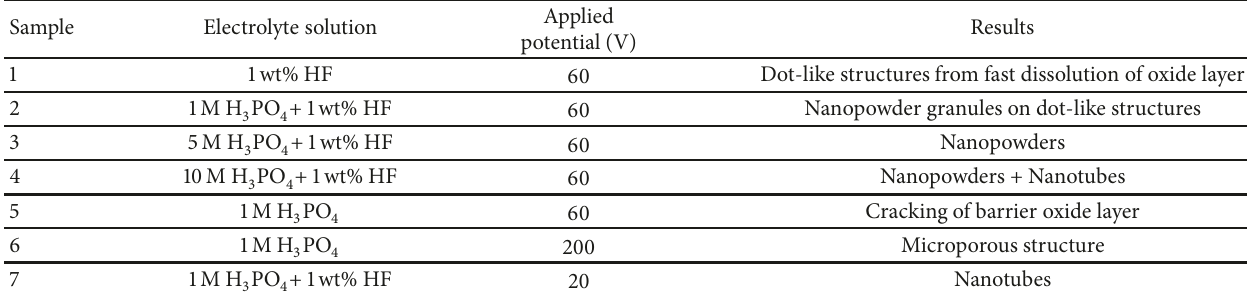
Table 2: Various electrolyte solutions and applied potentials used for anodizing Ti substrates [39].